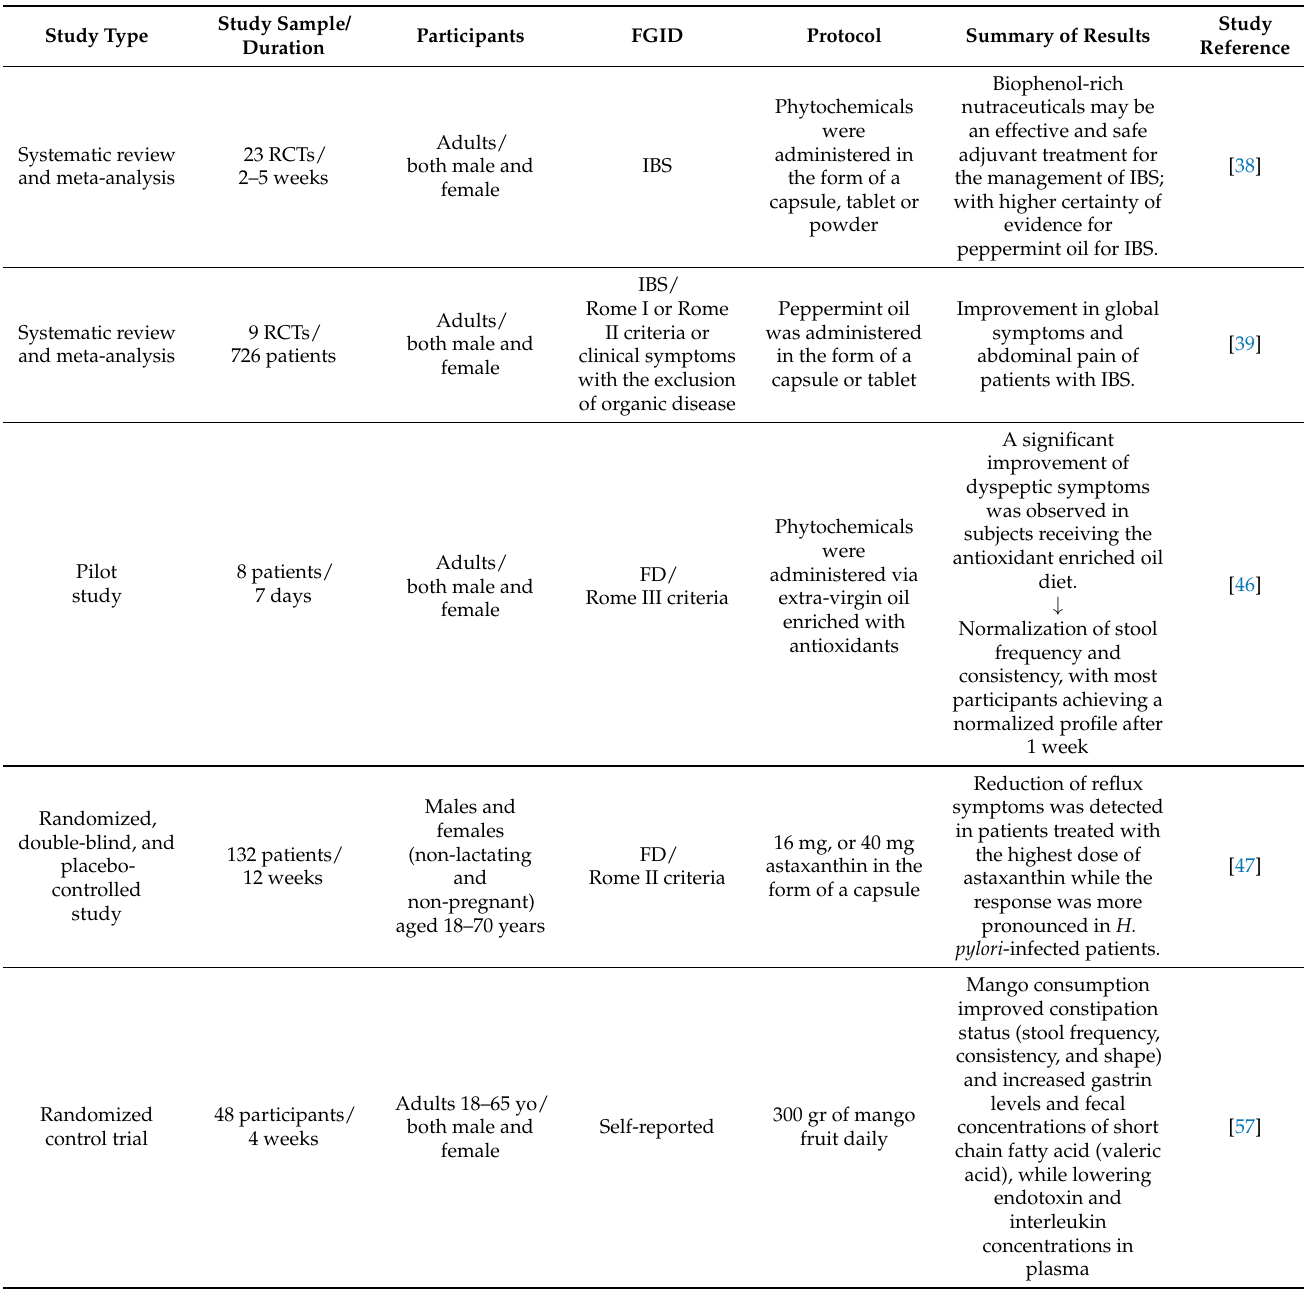
Table 4. Studies that summarize the efficacy of phytochemicals in treating irritable bowel syndrome, functional dyspepsia, and functional